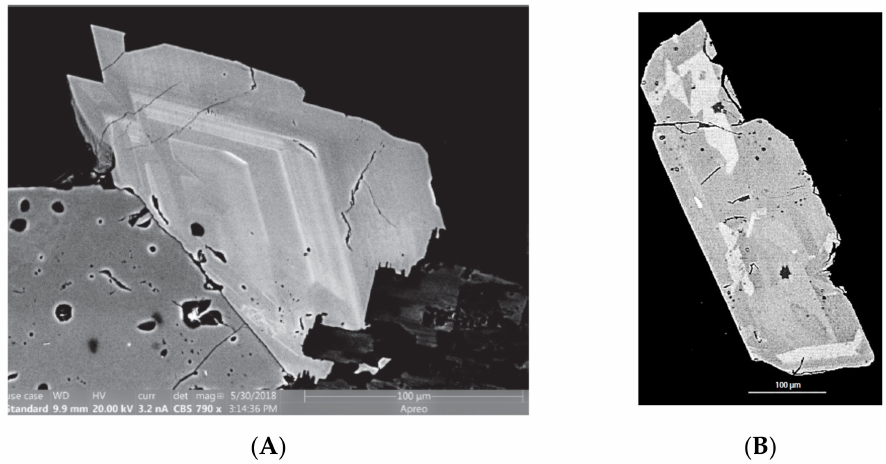
Figure 22. BSE images of titanite grains from silica-undersaturated rocks. ( A ) Euhedral titanite grain from ijolite xenolith in nepheline syenite from the Magnet Cove complex, Arkansas, with oscillatory zoning parallel to (111) crystal faces. ( B ) Euhedral titanite grain from the phonolitic Limberg t3 Tuff, Kaiserstuhl region, Germany, with patchy and oscillatory zoning.